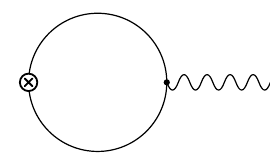
Figure 1 . The matrix element h (cid:13) j (cid:22) q(cid:27) (cid:22)(cid:23) q j 0 i